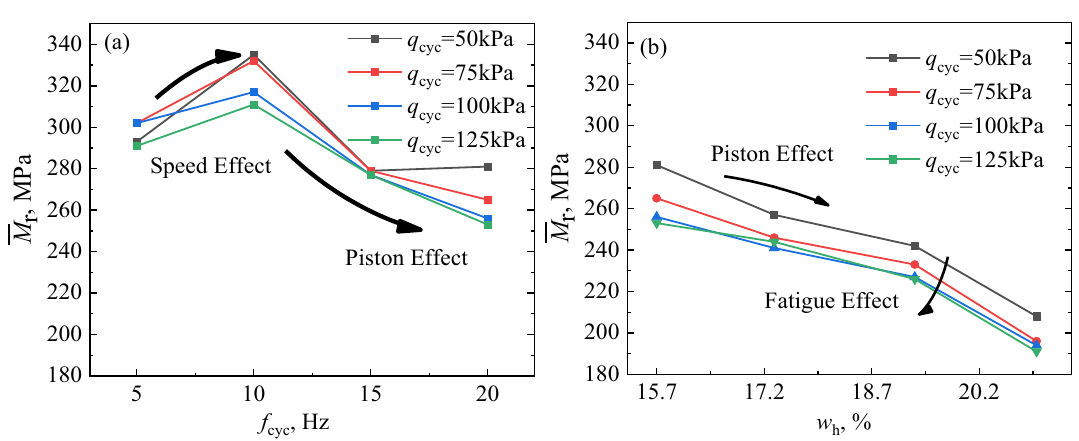
Figure 9. Evolution of kinetic effect based on the experimental data: ( a ) focusing on the effect of f cyc on M r , ( b ) focusing on the effect of w h .